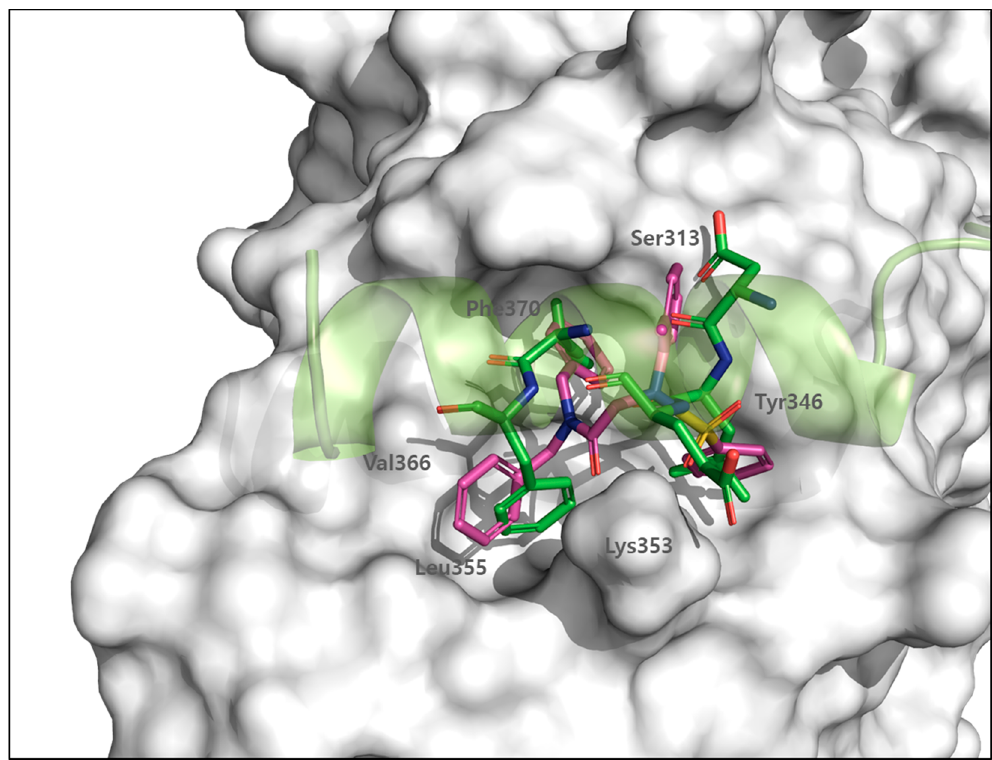
Figure 12. Overlay structure of BY03 to YAP at interface 2. The pink color represents BY03 and the green color represents YAP. Grey letters represent TEAD1 binding residues in interface 2 for BY03.